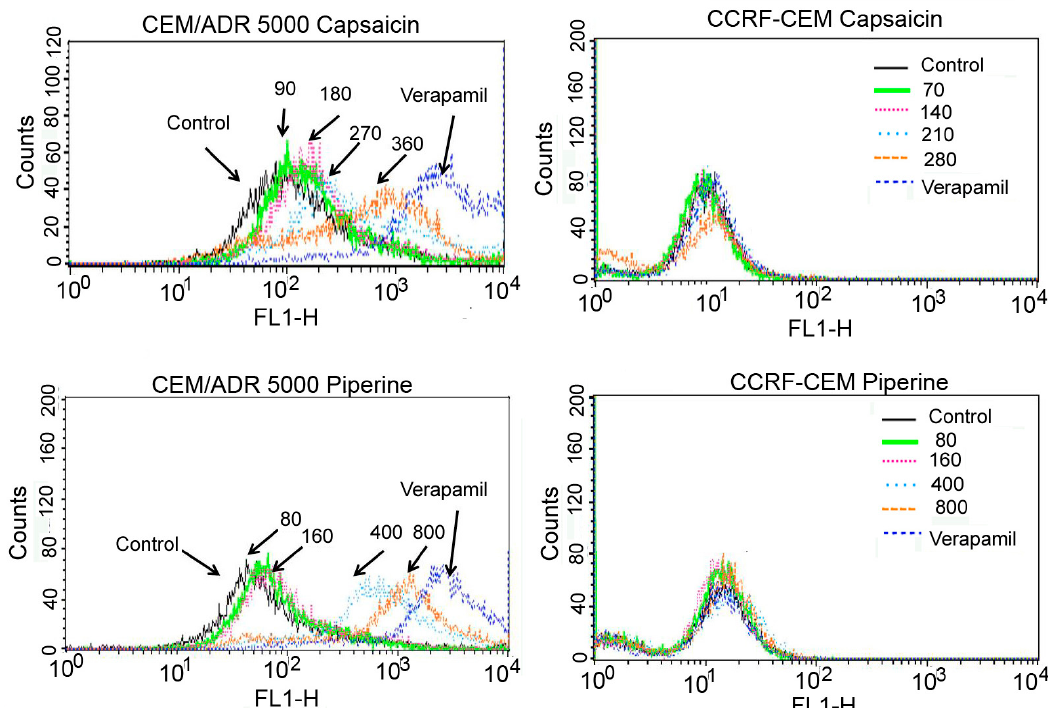
Figure 4. Histograms of flow cytometry of calcein accumulation in CEM/ADR 5000 and CCRF-CEM cells. Cells treated with DMSO were used as the negative control. The numbers drawn in this graph mean concentrations ( μ M) . Cells treated with 20 μ M verapamil were used as the positive control.